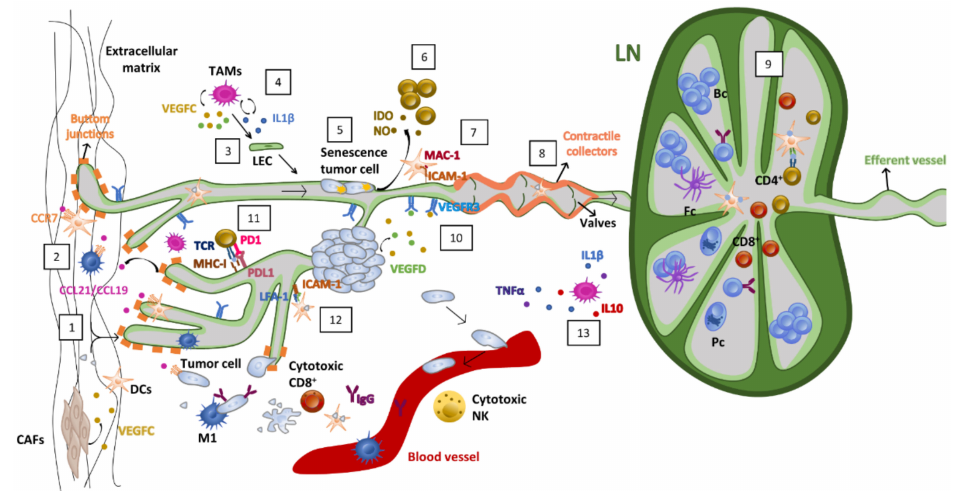
Figure 3. The Ying and Yang of the Lymphatic Vasculature in the Context of Tumor Microenviron- ment. Whereas the lymphatic system is essential in maintenance of internal homeostasis, it could also favor tumor cell metastasis: 1. Fluid and particle absorption through lymphatic capillaries; 2. Chemoattractant migration gradient of immune and tumoral cells driven by CCR7-CCL21/CCl19 interaction; 3. Macrophage transdifferentiation into LECs; 4. IL1 β and VEGFC induce LEC pro- liferation and migration; 5. Tumor cells can acquire a senescence state while migrating through the lymphatic system; 6. IDO and NO factors released from LECs can lead to T cell proliferation inhibition; 7. MAC-1 and ICAM-1 interaction induce DC maturation inhibition; 8. Lymph pressure, together with muscles and valves on contractile collectors, impulse cells into LN; 9. B cell matu- ration and activation takes place on LN together with T cell activation, expansion and migration; 10. VEGFC/D ligands released by some tumoral, fibroblastic and immune cells, generate an incre- ment in permeability, lymphangiogenesis and metastasis while interacting with VEGFR3 receptors on lymphatic vessels’ surfaces; 11. LECs can express PDL1 on each surface, playing a fundamental role in peripheral tolerance balance; 12. Leukocyte migration under inflammation is driven by LFA-1 and ICAM-1 interaction; 13. Some inflammatory cytokines such as IL1 β , TNF α and IL10 can attract VEGFC-secreting leukocytes. TAMs, tumor associated macrophages; VEGFC/D, vascular endothelial growth factor C/D; LEC, lymphatic endothelial cell; IDO, indoleamine-pyrrole 2,3-dioxygenase; NO, nitric oxide; MAC-1, macrophage-1 antigen; ICAM-1, intercellular adhesion molecule 1; VEGFR3, vascular endothelial growth factor receptor 3; LN, lymph node; Bc, B cells; Fc, follicular cells; Pc, plasma cells; TNF α , tumor necrosis factor; IL1 β , interleukin 1 β ; IL10, interleukin 10; NK, natural killer cell; LFA-1, lymphocyte function-associated antigen-1; TCR, T-cell receptor; MHC-I, major histocompatibility complex I; PD1/PDL1, programmed death-1/programmed death ligand-1; CCR7, C-C chemokine receptor type 7; CCL21/19, C-C chemokine ligand 21/19; DCs, dendritic cells; CAFs, cancer associated